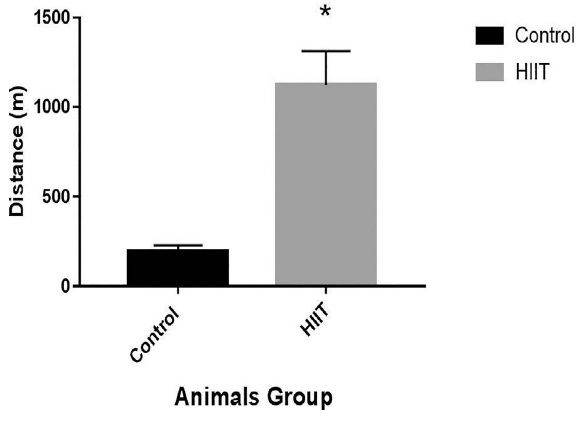
Figure 5 - Comparison of performance between control and HIIT train- ing rats after eight weeks. (*) Statistical difference presented by the Stu-